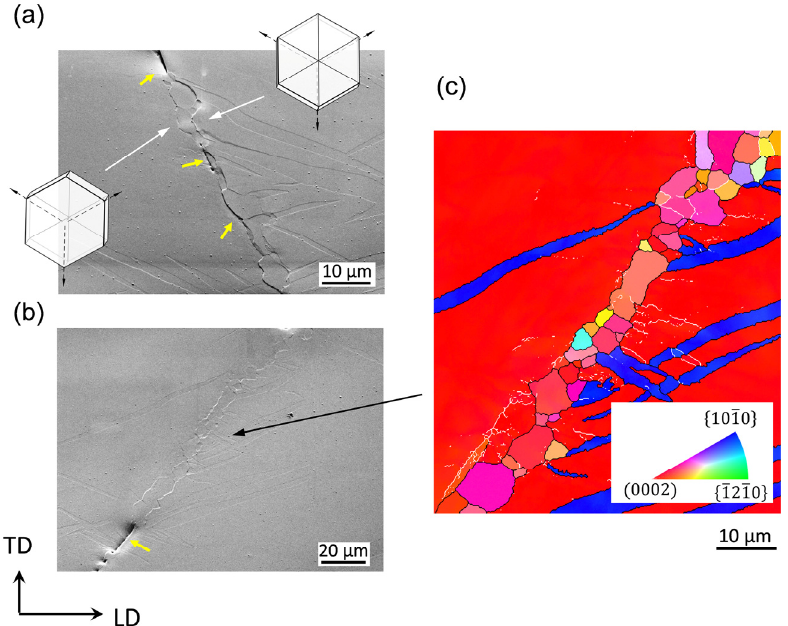
Figure 8. ( a , b ) SEM micrographs of recrystallized bands and cracks on the TD ‐ LD surface and ( c ) orientation map of the band in ( b ) in inverse pole figure (IPF) coloring with respect to CD. Yellow arrows in ( a , b ) indicate cracks.